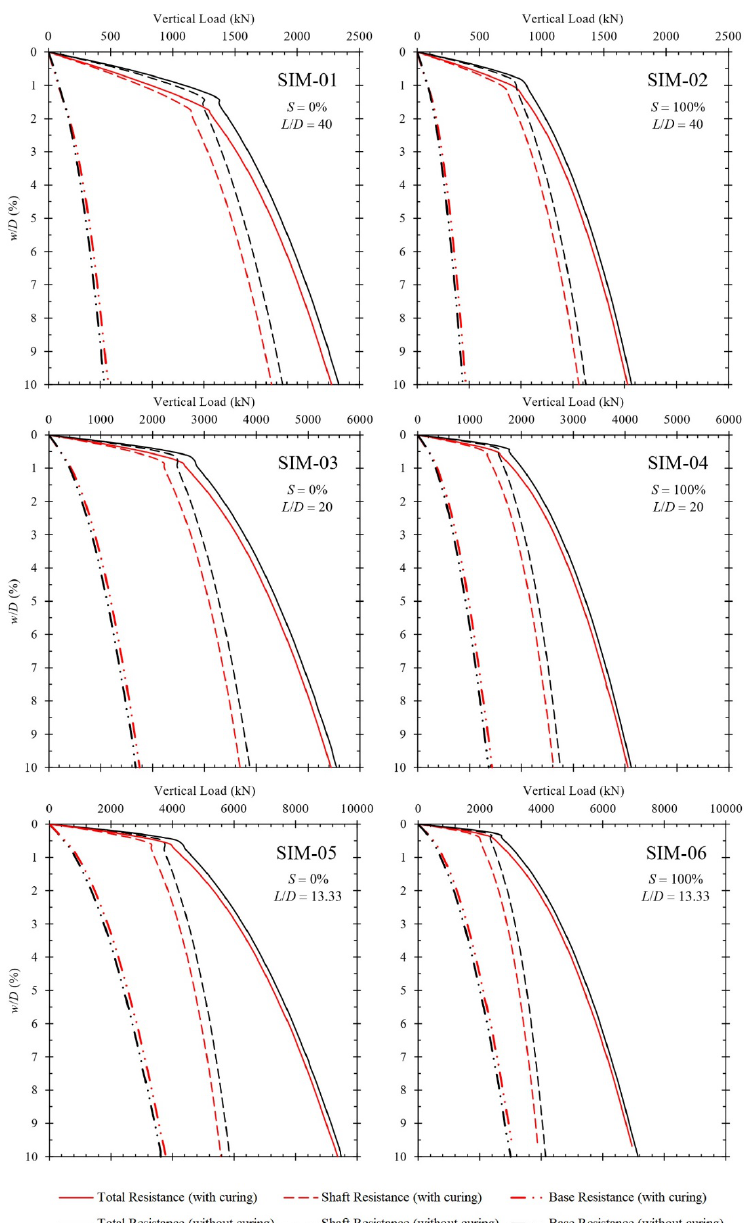
Figure 14. Load-settlement curves for 20 m long drilled shafts for analyses with L / D = 40 (SIM-01 and SIM-02), L / D = 20 (SIM-03 and SIM-04), and L / D = 13.33 (SIM-05 and